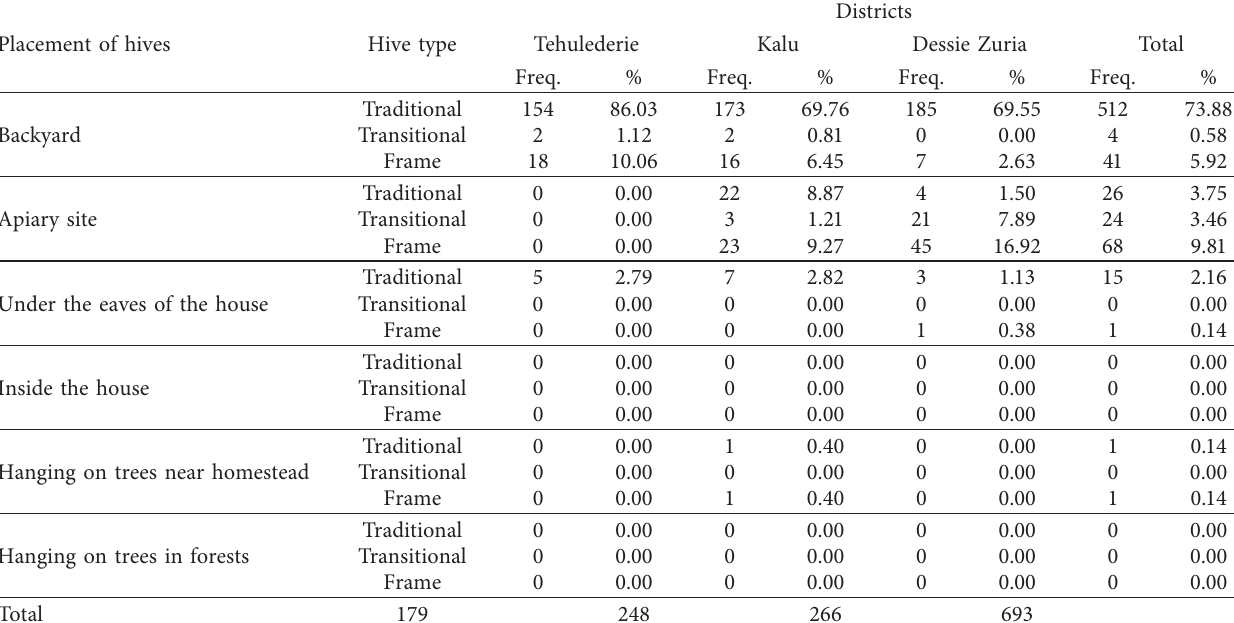
Table 7: Placement of beehives in the study areas.